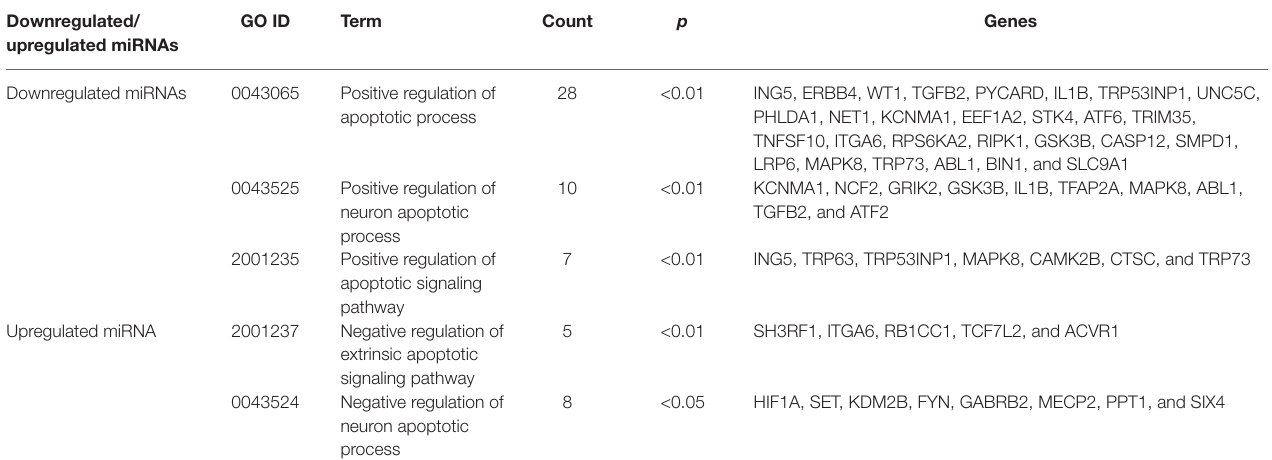
TABLE 5 | Pro-apoptosis related biological processes from GO analysis. Downregulated/ upregulated